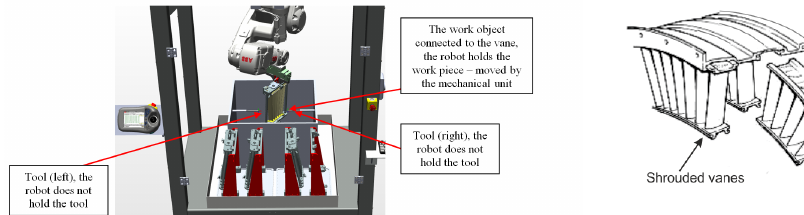
Figure 3: Measurement